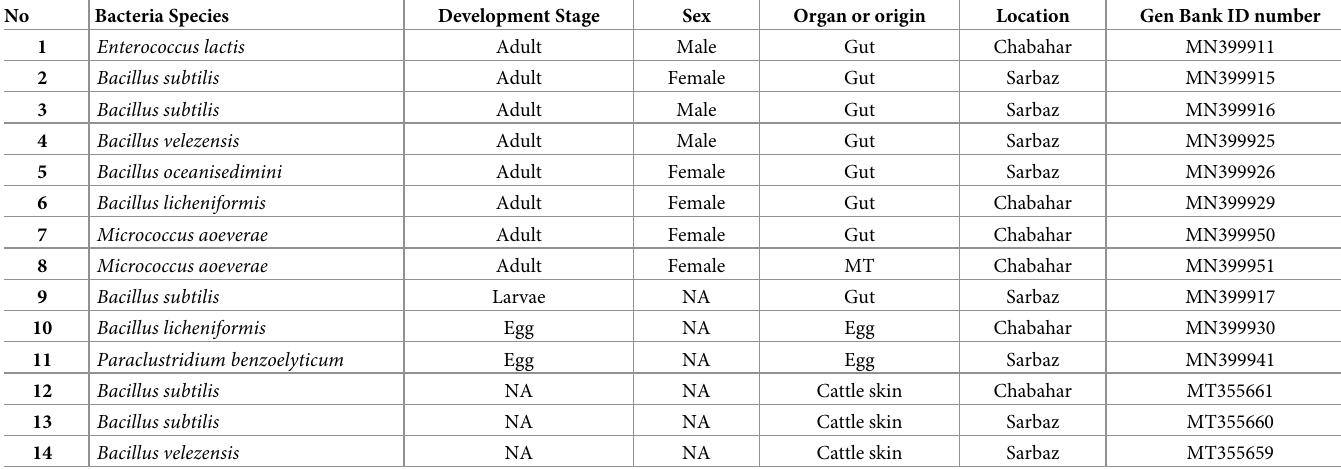
Table 2. Bacterial profile of H . anatolicum ticks and their host skin (ear) revealed by culture dependent method. No Bacteria